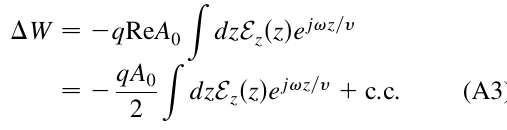
FIG. 5. (Color) The sum of the loss factors a 2 P a 2 W (cid:3) 0 (cid:9) (cid:5) = 2 ] as a function of (cid:23)a=w (solid line). Also shown are the contribution of the first mode, a 2 (cid:4) the approximation 8 (cid:3) (cid:23)a=w (cid:5) 2 exp (cid:3)(cid:4) 2 (cid:23)a=w (cid:5) (dotted